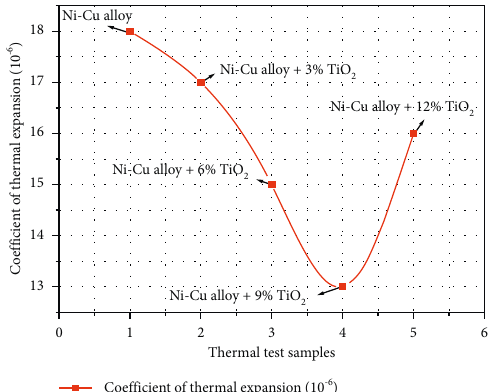
Figure 9: Thermal expansion of the nanocomposites.